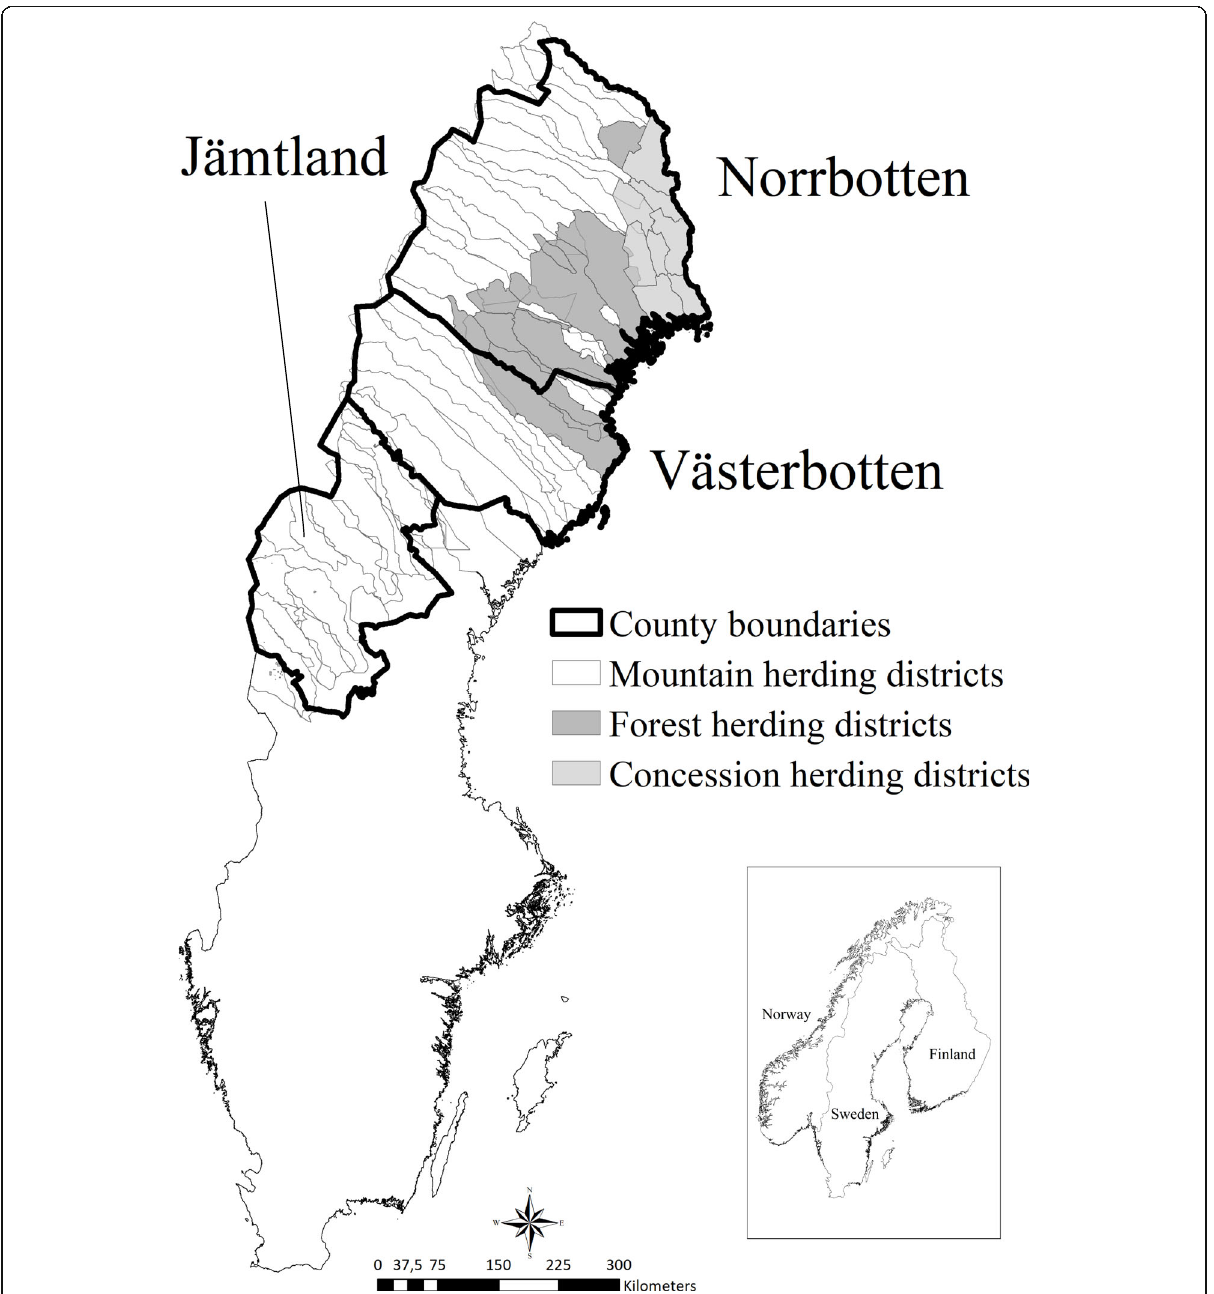
Fig. 1 Map of the Swedish reindeer herding area. Boundaries of the 51 Swedish reindeer herding districts. Reindeer belonging to the mountain herding districts migrate between winter pastures in the east, close to the Baltic coast, and summer pastures on the Scandinavian mountain chain in the west. Forest and concession herding districts remain in the boreal forest year around. The winter ranges of mountain districts partly overlap with land of the forest